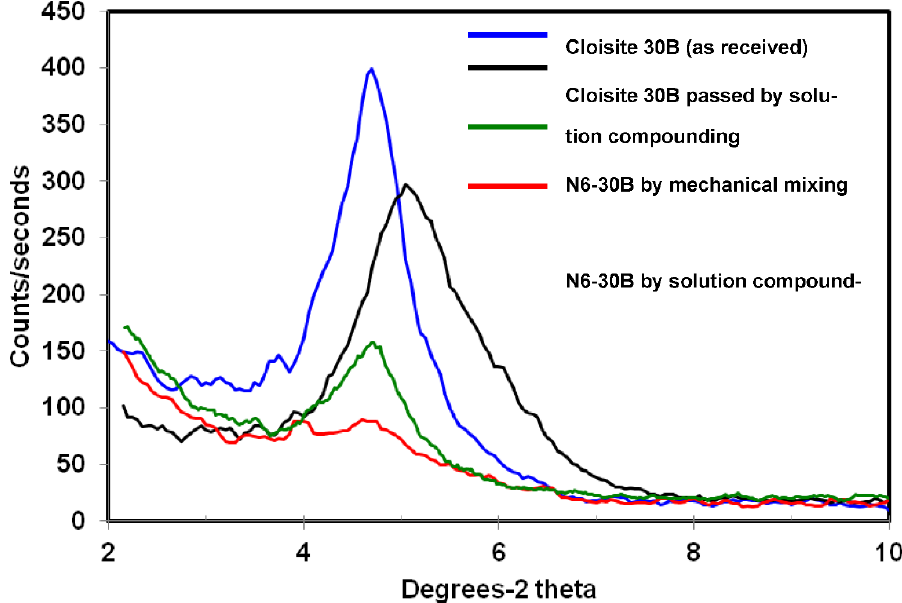
Figure 3. XRD diffraction patterns for the different 30B and 30B composite samples.